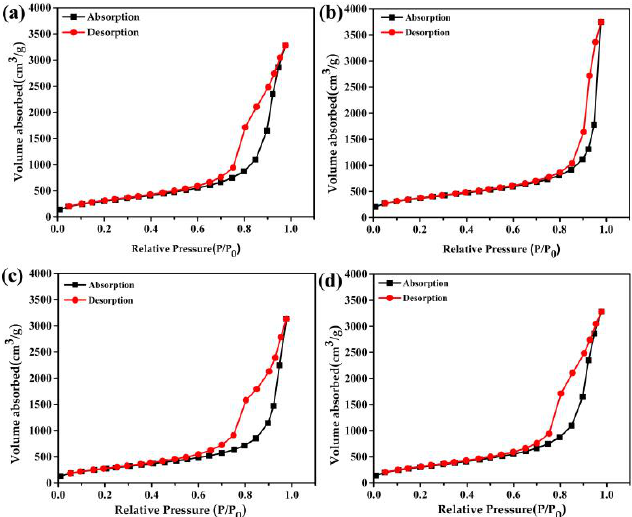
Figure 4. Nitrogen adsorption and desorption isotherms of CO 2 -SPD aerogels before ( a ) and after ( b ) the first thermal shock, and ethanol-SPD aerogels before( c ) and after ( d ) the first thermal